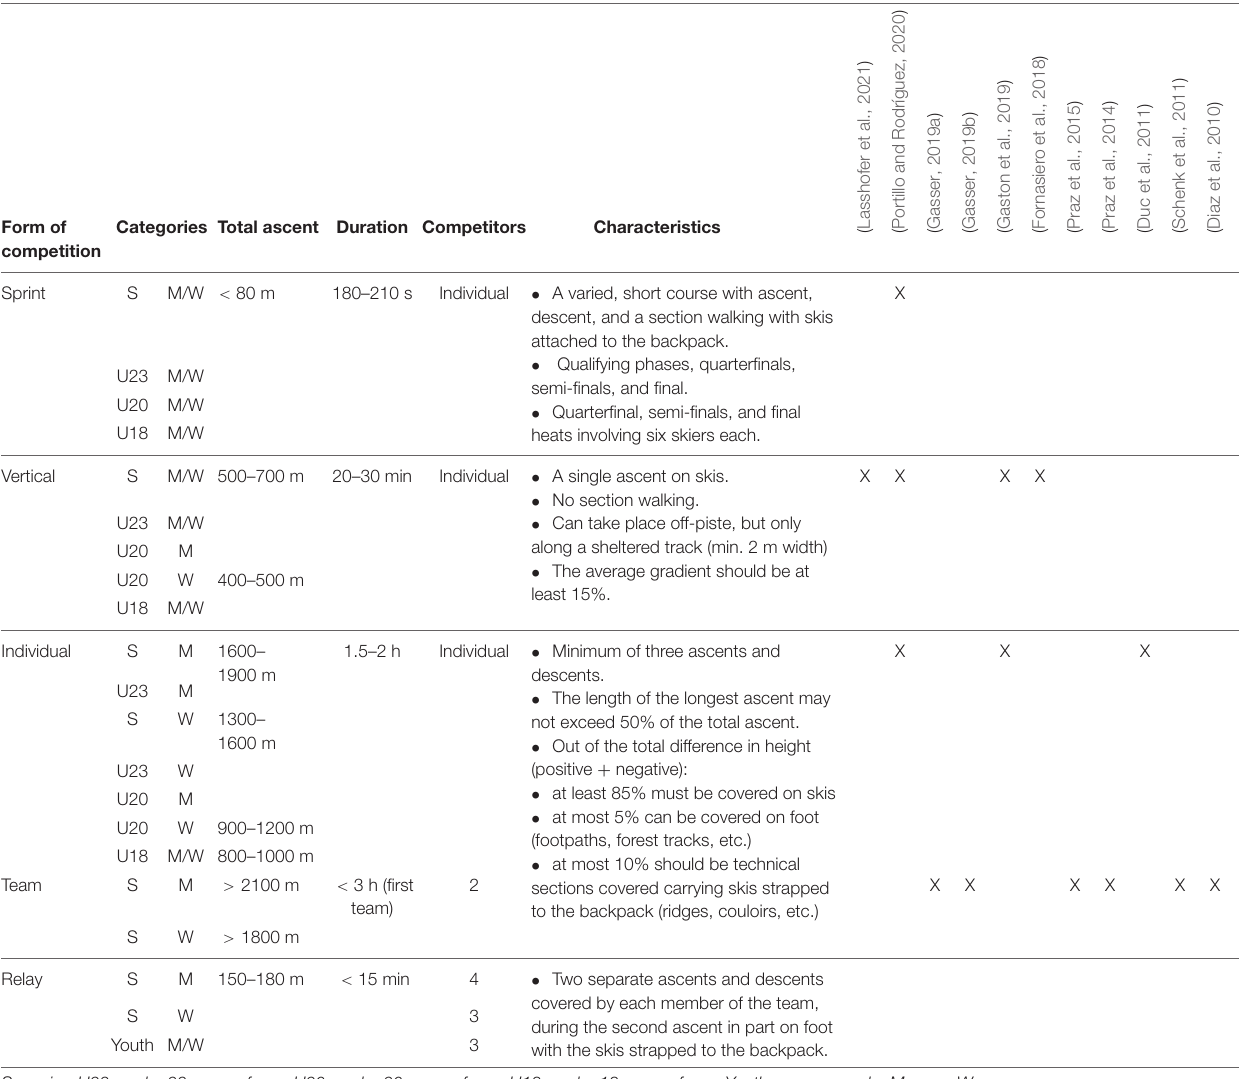
TABLE 1 | General features of ISMF races and publications that deal with their characteristics.